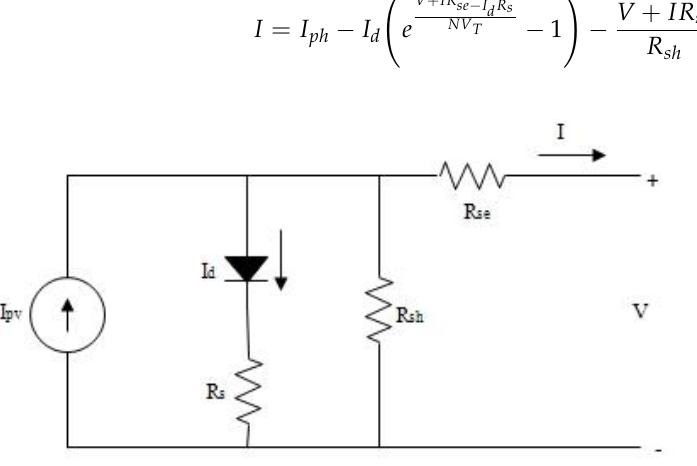
Figure 2. Schematic diagram of the modified single-diode PV model.